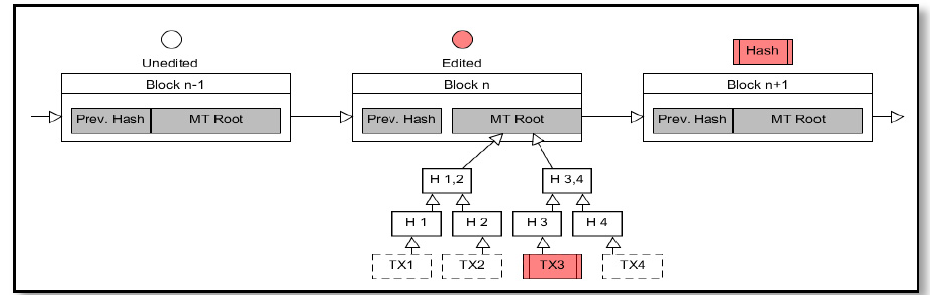
Figure 6. Derler proposal.